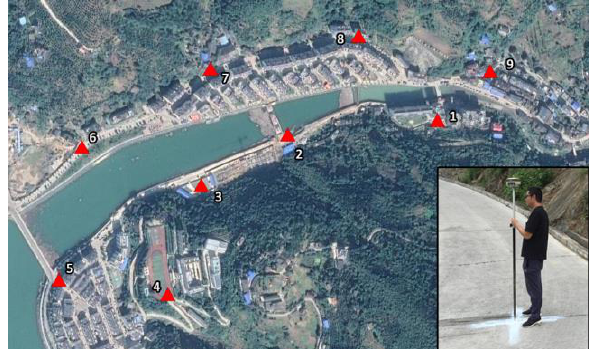
Figure 4. GCP locations in relation to the study